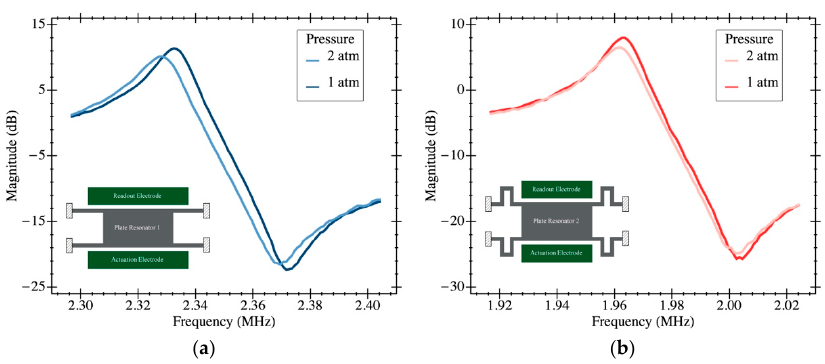
Figure 10. Magnitude plot of the system transmission coefficient in ambient pressure and overpressure (2 atm) operation with a DC biasing voltage of 30 V for each resonator: ( a ) PR1; ( b ) PR2. When increasing the operating pressure, the quality factor decreases and, as a consequence, so does the resonance frequency.